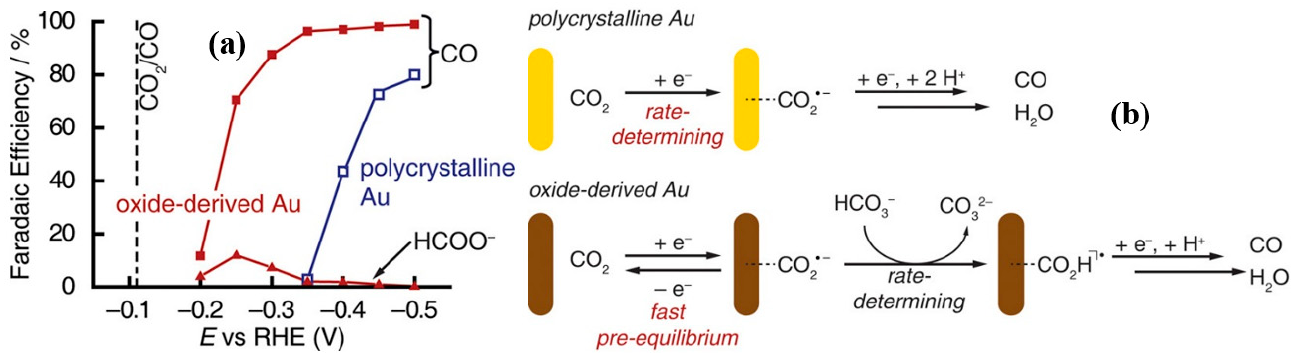
Figure 2. ( a ): FEs for CO and HCO 2– production on oxide-derived Au and polycrystalline Au electrodes at various potentials between − 0.2 and − 0.5 V in 0.5 M NaHCO 3 , pH 7.2. Dashed line indicates the CO equilibrium potential. ( b ): suggested mechanisms for CO 2 reduction to CO on polycrystalline Au and oxide-derived Au (Reprinted with permission from Ref. [74]. Copyright 2016 Wiley-VCH).